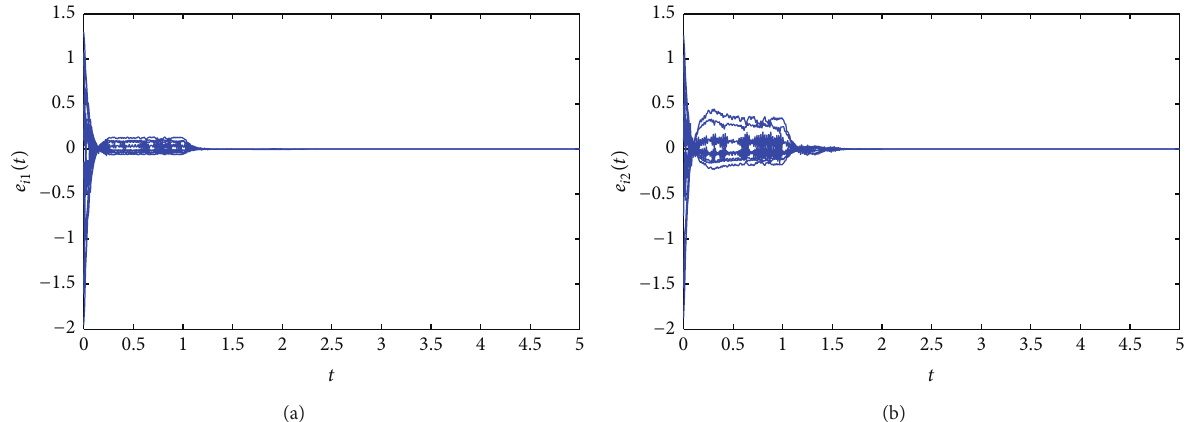
Figure 3: The time evolution of 𝑒 𝑖1 and 𝑒 𝑖2 ( 𝑖 = 1,2,...,7 ) in system (46) by impulse